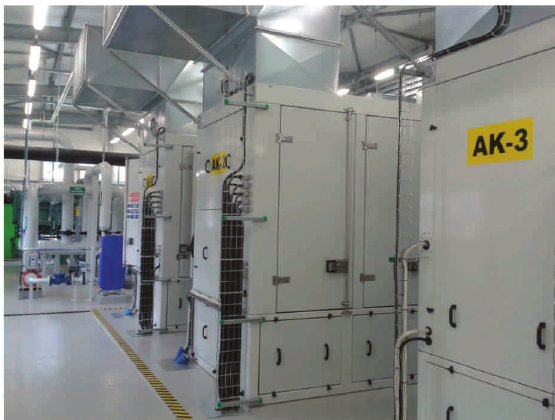
Fig. 6. Power generators with electronically controlled, post-processing gas injection system, located in one of the “AZOTY S.A.” plants Measurements made during the operational tests of the 6-cylinder AK-3 engine showed that in the case of